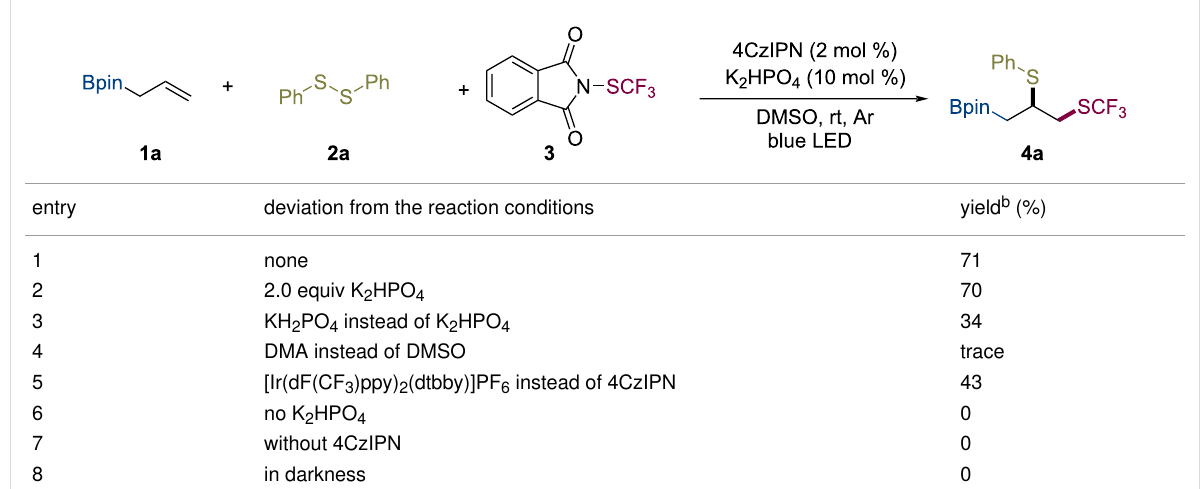
Table 1: Optimization of the reaction conditions. a